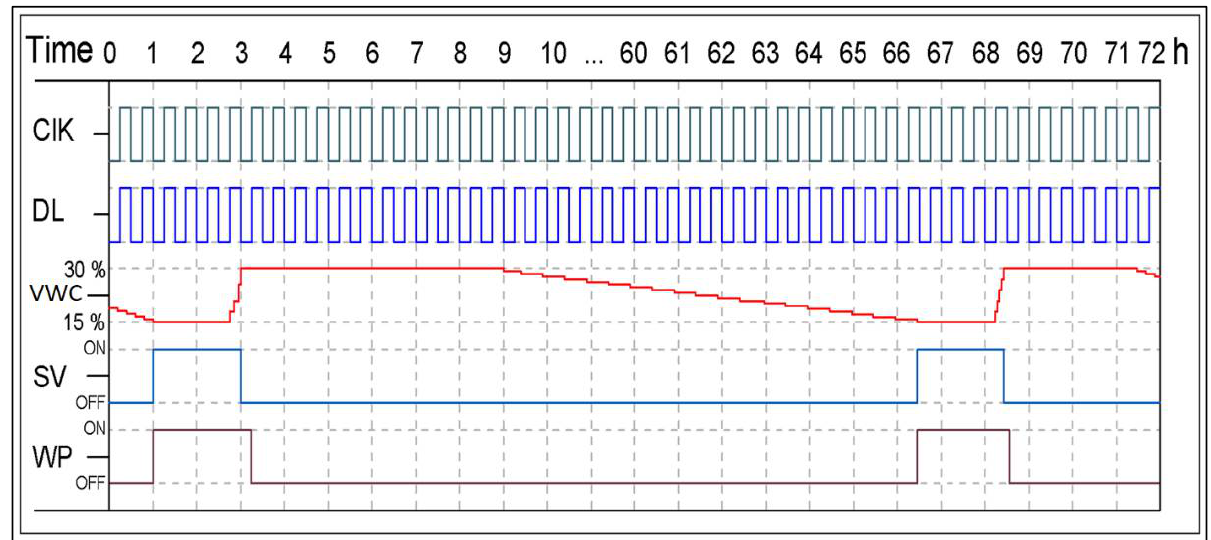
Figure 11. The ON and OFF control action timing diagram. ClK is clock of timing, DL is data logging, VWC is the measured volumetric water content, SV is the solenoid valve, and WP is the water pump.